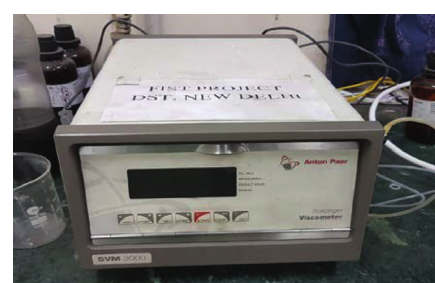
Figure 4: Experimental setup of Stabinger viscometer SVM30.